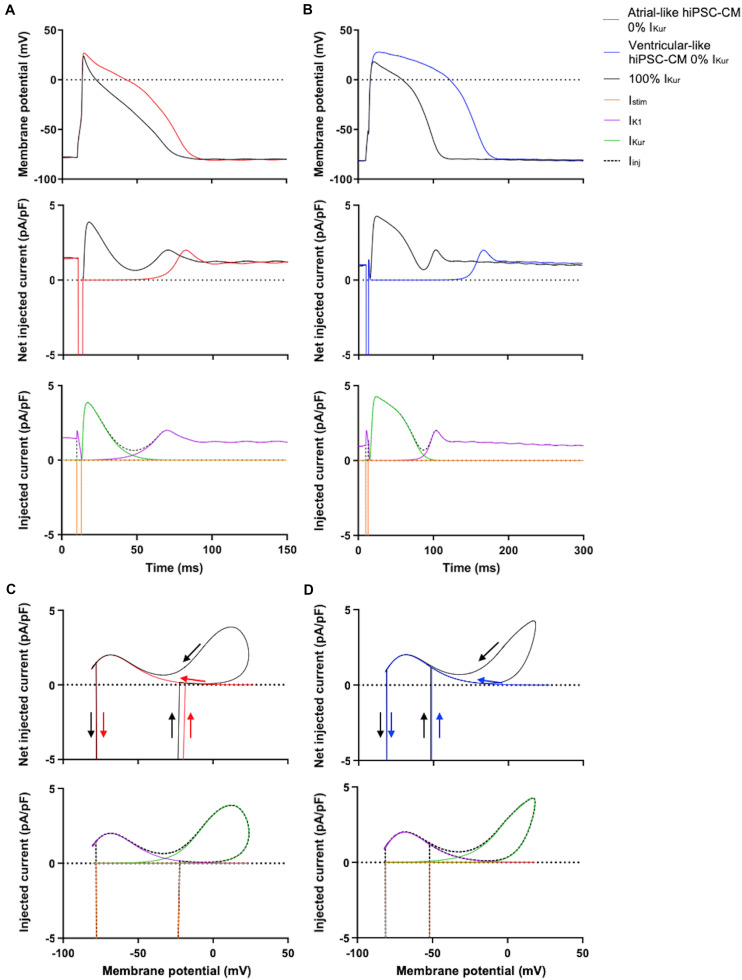
Effect of injection of 100% virtual IKur through dynamic clamp on APs of atrial- and ventricular-like hiPSC-CMs. (A) Superimposed APs (top panel) of an atrial-like hiPSC-CM at 0% (red line) and 100% virtual IKur (black line) and associated net injected current (middle panel), consisting of IK1, 0% or 100% IKur, and a short stimulus current, as shown in the bottom panel in case of 100% IKur. (B) Superimposed APs (top panel), associated net injected current (middle panel), and its individual components in case of 100% IKur (bottom panel) of a ventricular-like hiPSC-CM. (C,D) Phase plane plots (top panel) of the action potentials and injected currents of panels (A,B) with their individual components in case of 100% IKur (bottom panel). APs elicited at 1 Hz by a 3-ms stimulus of 100 pA. Note difference in time scale between panels (A,B).